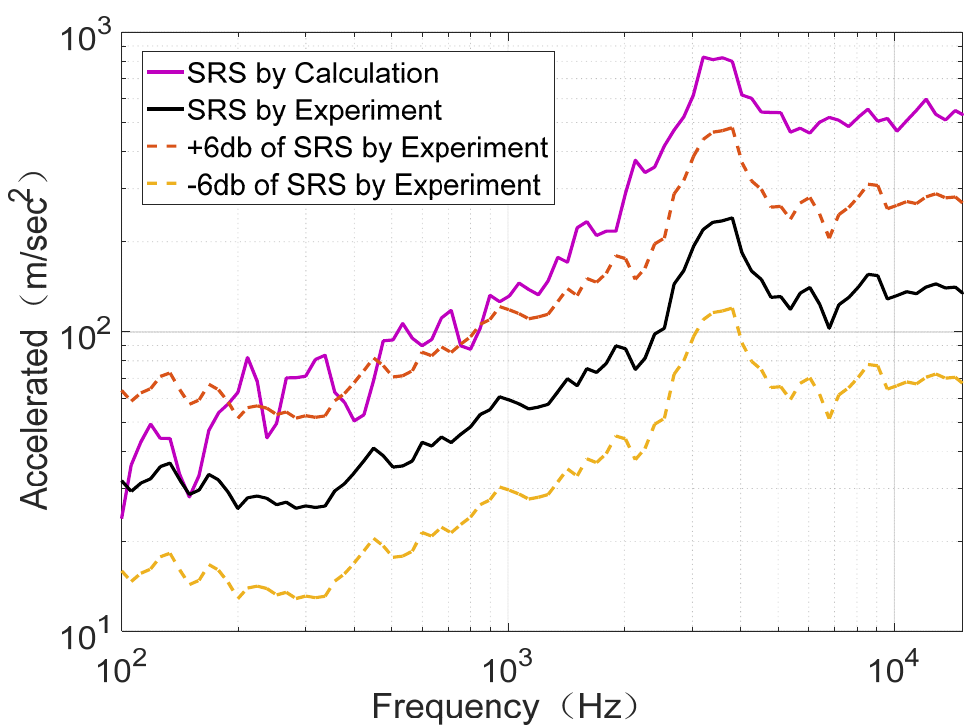
Figure 13. Shock responses of experiment and calculation for plate 4.